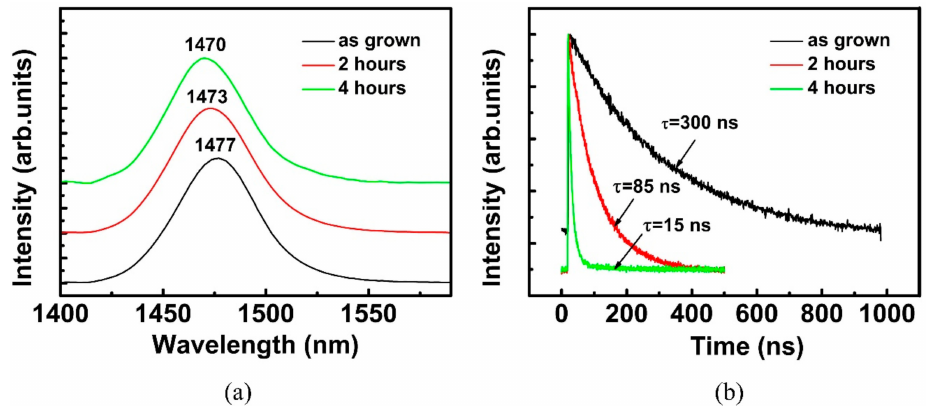
Figure 3. ( a ) Room temperature (300 K) photoluminescence spectra of Al 0.07 Ga 0.22 In 0.71 As QW thermally treated with different durations at 170 ◦ C. ( b ) Time-resolved photoluminescence (PL) spectra of sample as grown, after 2 h and 4 h (respective emission wavelength centered at 1477 nm, 1473 nm, and 1470